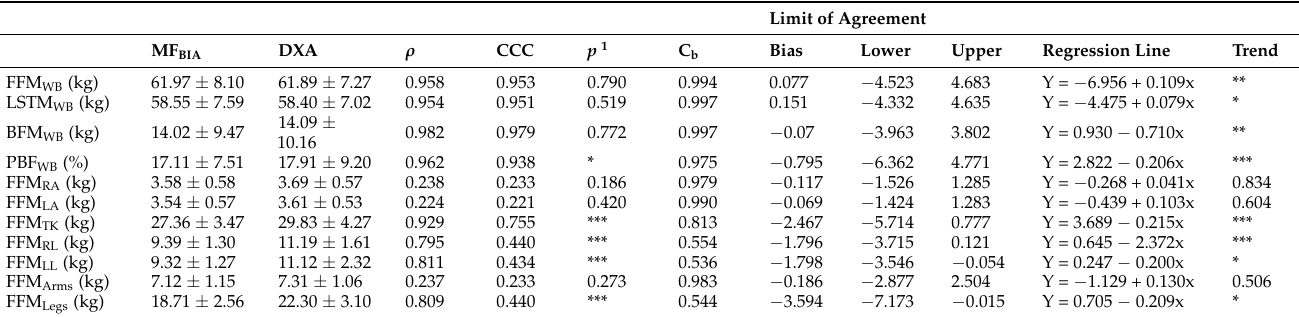
Table 2. Correlation of body composition estimates using Pearson product moment correlation and Bland–Altman plot.